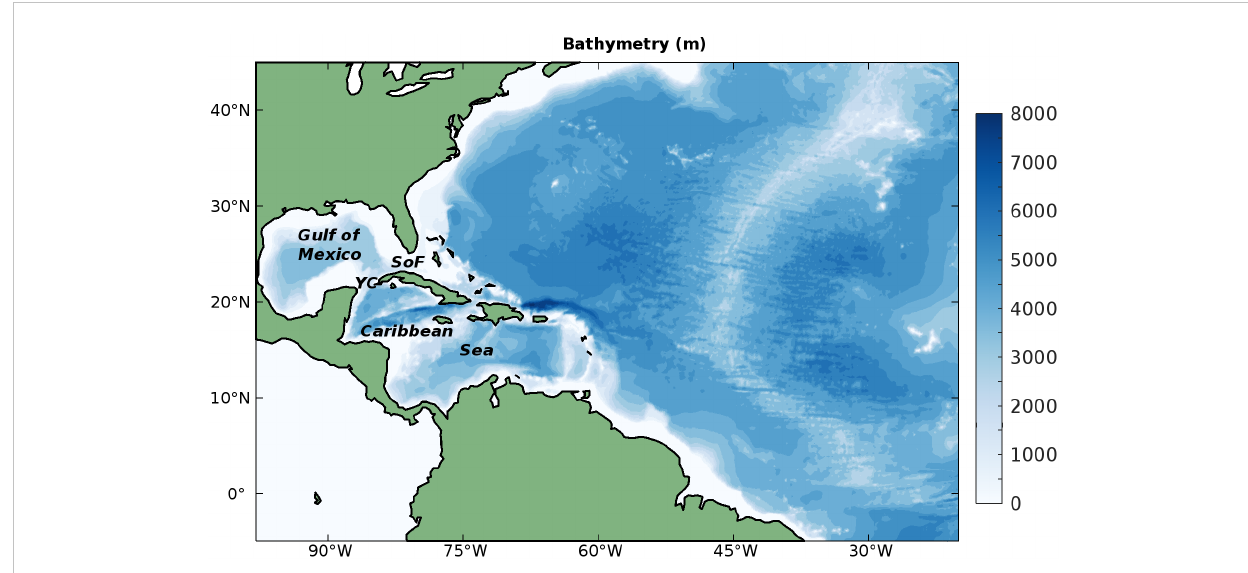
FIGURE 1 Model domain and bathymetry of the North Atlantic used in this study, with the main toponyms mentioned in the text (YC, Yucatan Channel; SoF, Straits of